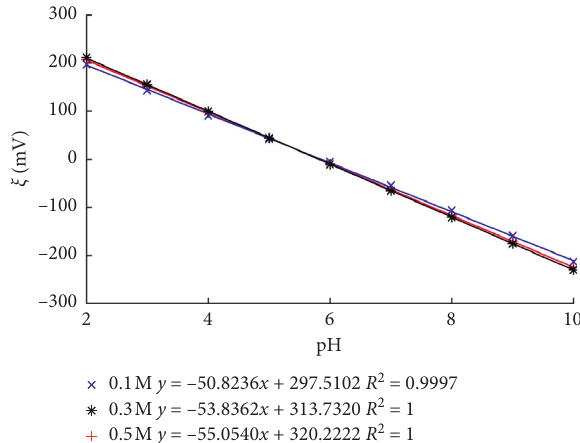
Figure 3: Total electrode potential ξ against pH at 120 μ F/cm 2 based on parameters from Dimitri [30] for different electrolyte ionic